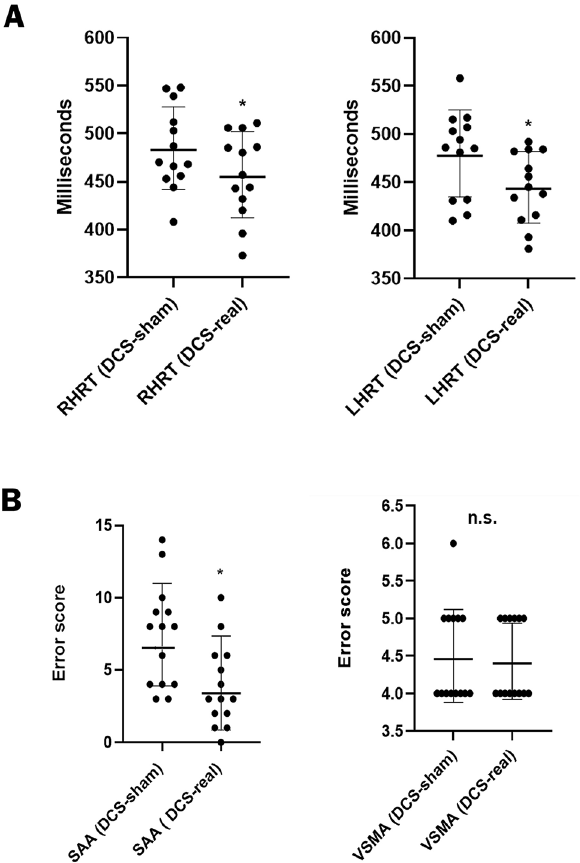
Figure 2. ( A ): Dot plots representing the participants’ performance for the reaction time task (RHRT: Right hand reaction time; LHRT: Left hand reaction time). ( B ): Dot plots representing the participants’ performance for the selective attention and visuospatial memory tasks (SAA.: Selective attention assessment; VSMA.: Visuospatial memory assessment). *Significant; ns: Non-significant. (Selective attention p < 0.0003, Right hand reaction time p < 0.0001 and Left hand reaction time p <